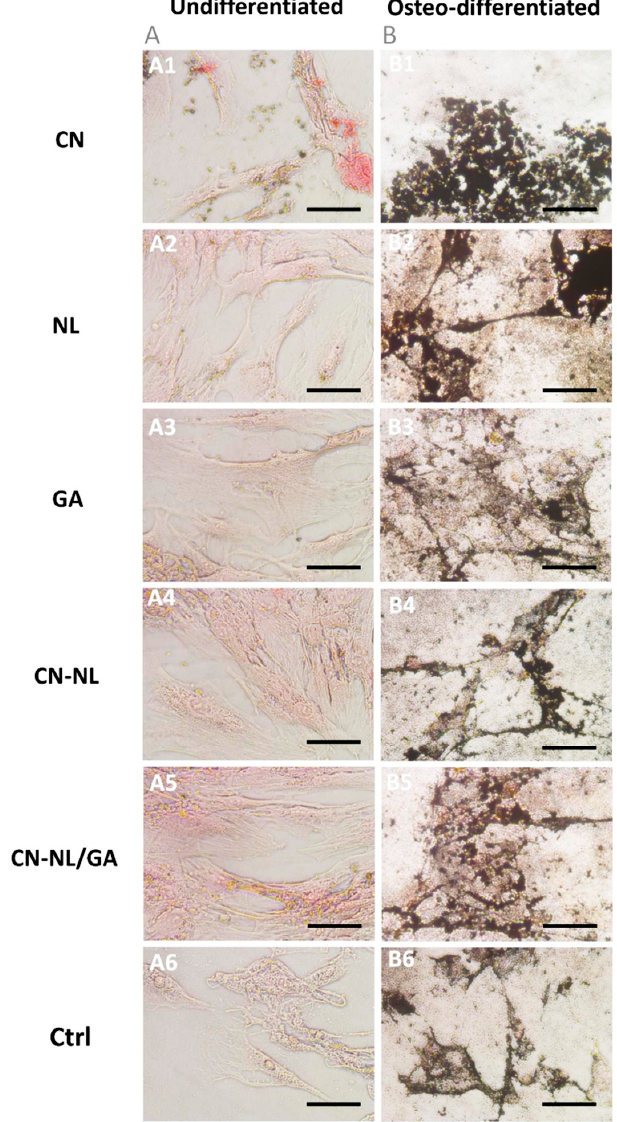
Figure 9. Light micrographs of von Kossa staining performed on ( A ) undifferentiated (control) and ( B ) osteodifferentiated hMSCs after incubation with all the nanocomponents (CN, NL, GA, CN-NL, CN-NL/GA) for 15 days at the highest concentrations in the tested ranges. Original magnification 200×; scale bar = 100 µm.